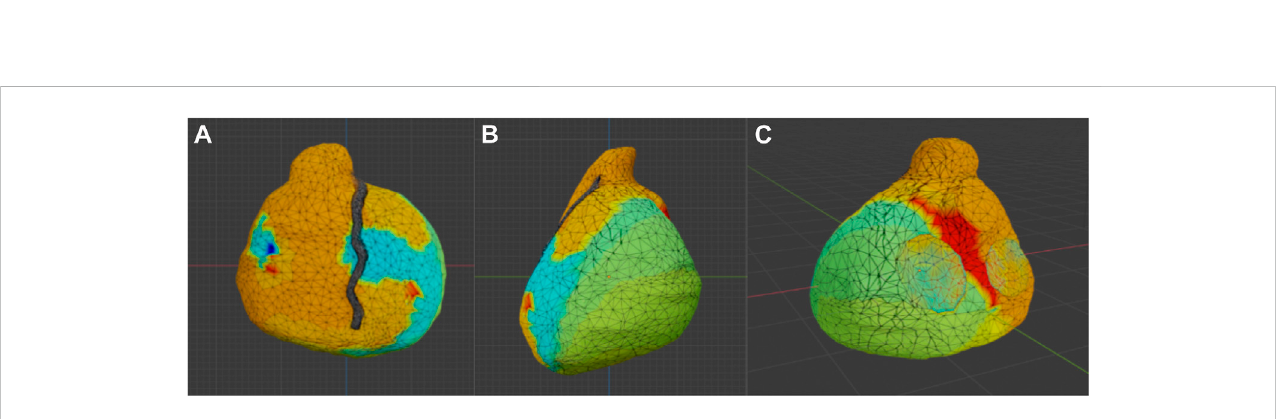
FIGURE 2 Model produced with photogrammetry. Photogrammetric reconstruction view in Blender. (A) Antero-posterior view; (B) Latero-lateral view, (C) Postero-anterior